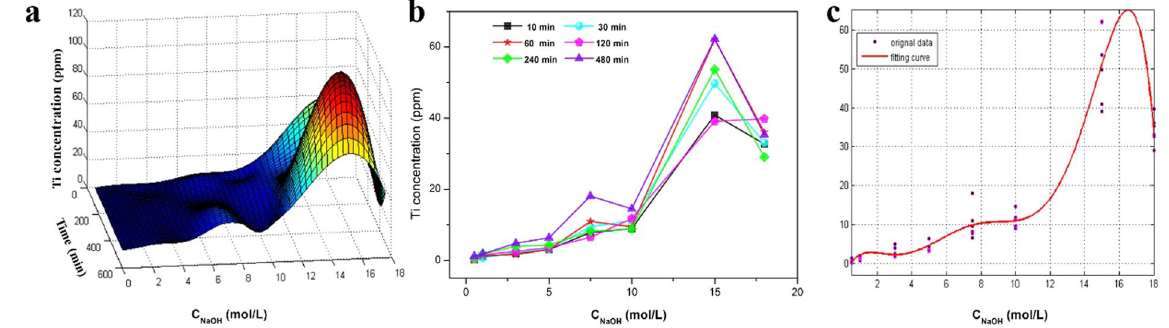
Figure 4. The 3D graph of Ti concentration as a function of NaOH concentration and treating time ( a ), and the functional relationship of Ti concentration vs. NaOH concentration ( b ), ( c ) fitting curve of Ti concentration vs. NaOH concentration.